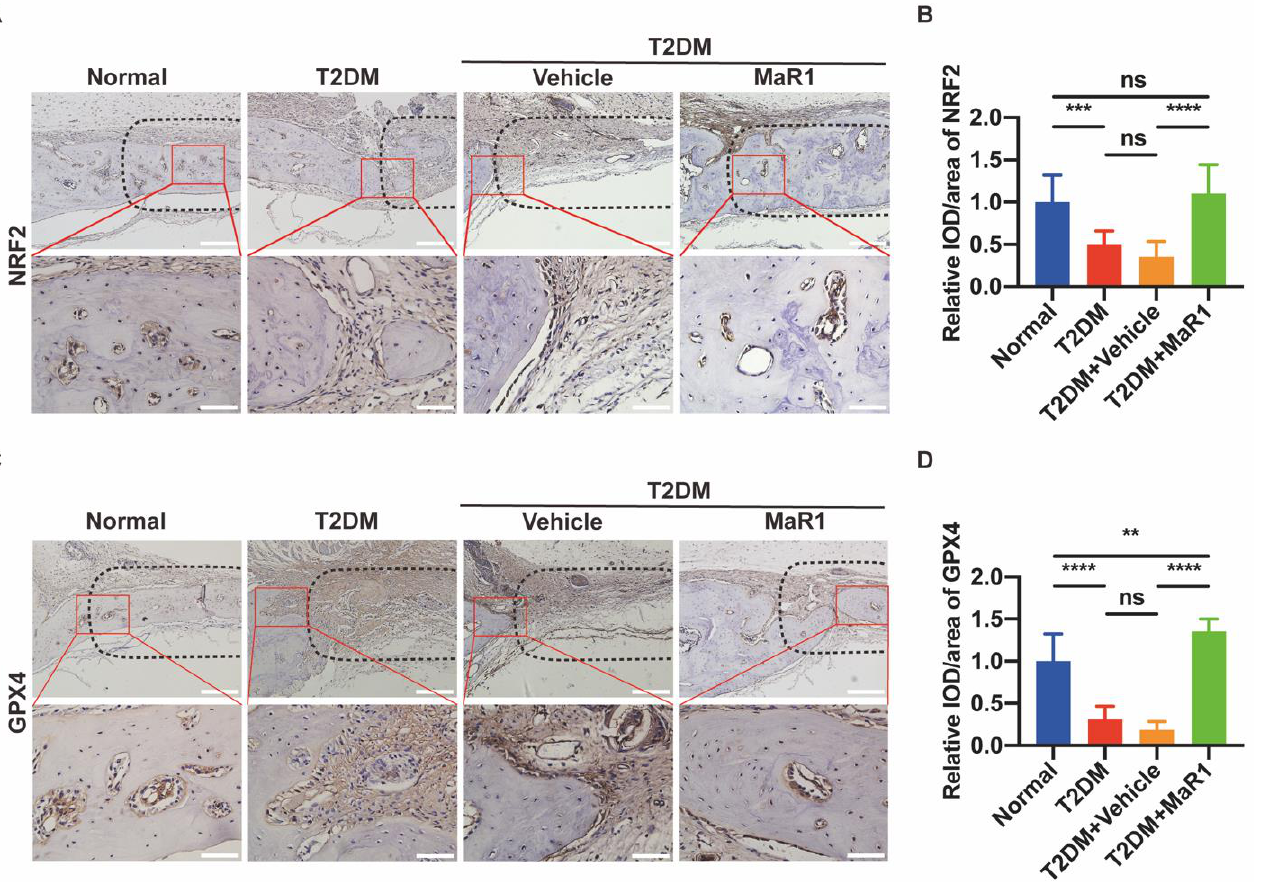
Figure 6. MaR1 enhances the expression of NRF2 and GPX4. ( A ) NRF2 protein immunohistochemistry staining. Scale bar = 200 μm and 50 μm. ( B ) A quantitative examination of NRF 2′ s mean integral optical density. ( C ) GPX4 protein immunohistochemistry pictures. Scale bar = 200 μm and 50 μm. ( D ) Mean integral optical density quantification analysis for GPX4. Data are